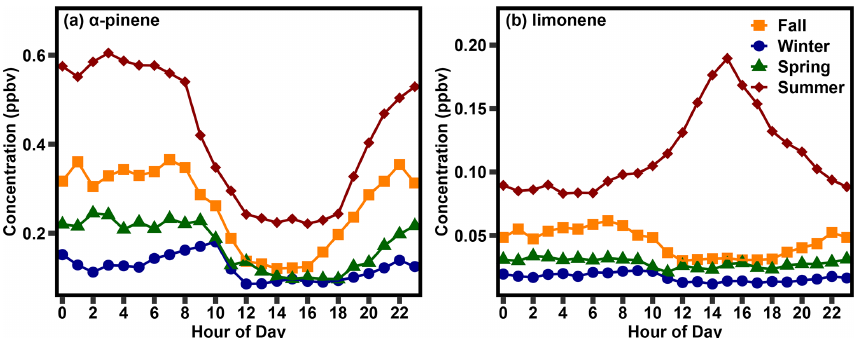
Figure 1. The mean (a) α -pinene and (b) limonene concentration in the four seasons of the Northern Hemisphere between September 2019 and September 2021.